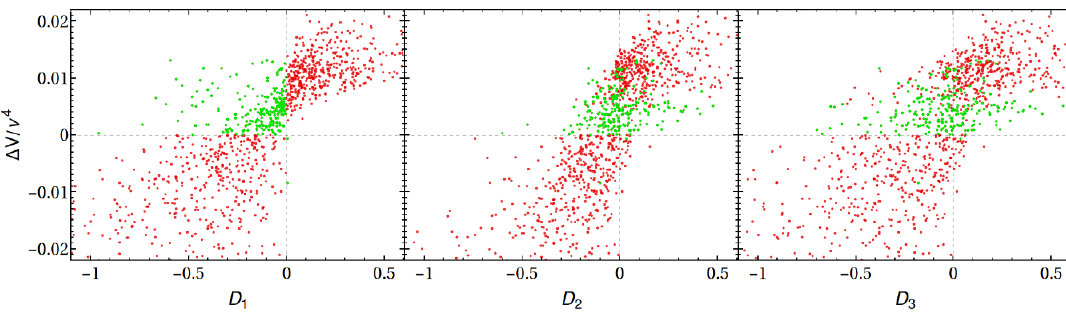
Figure 10 . Comparison of the three discriminants proposed in (7.1) in the case of non-regular points. The green points mark the cases where D 1 predicts the opposite depth